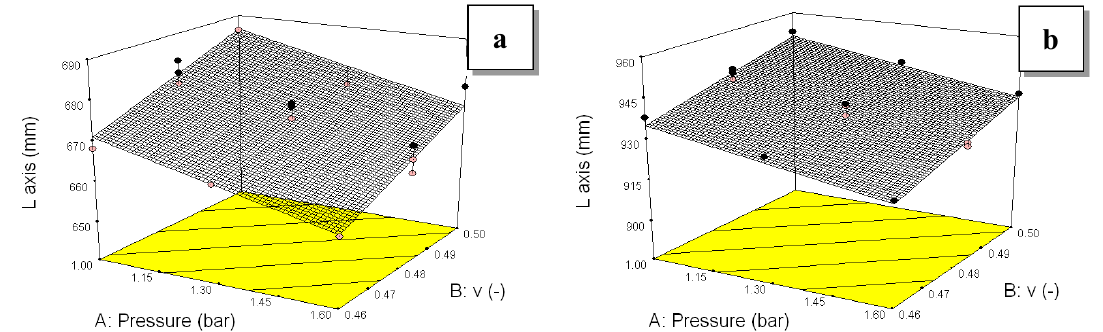
Figure 11. 3D representation of the interpolation models for the footprint longitudinal axis of the two tested tyres ( a : 420 / 85 R24; b : 460 / 85 R34) as a function of Poisson’s ratio and tyre inflating pressure.